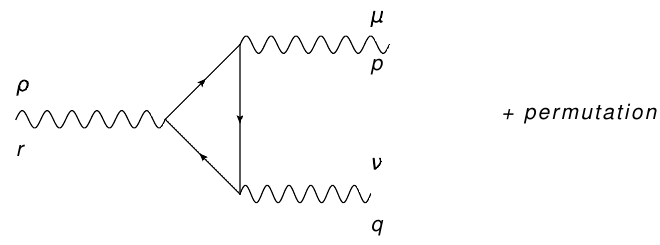
Figure 1. Generic fermion loop for Z 0 decay into two vector